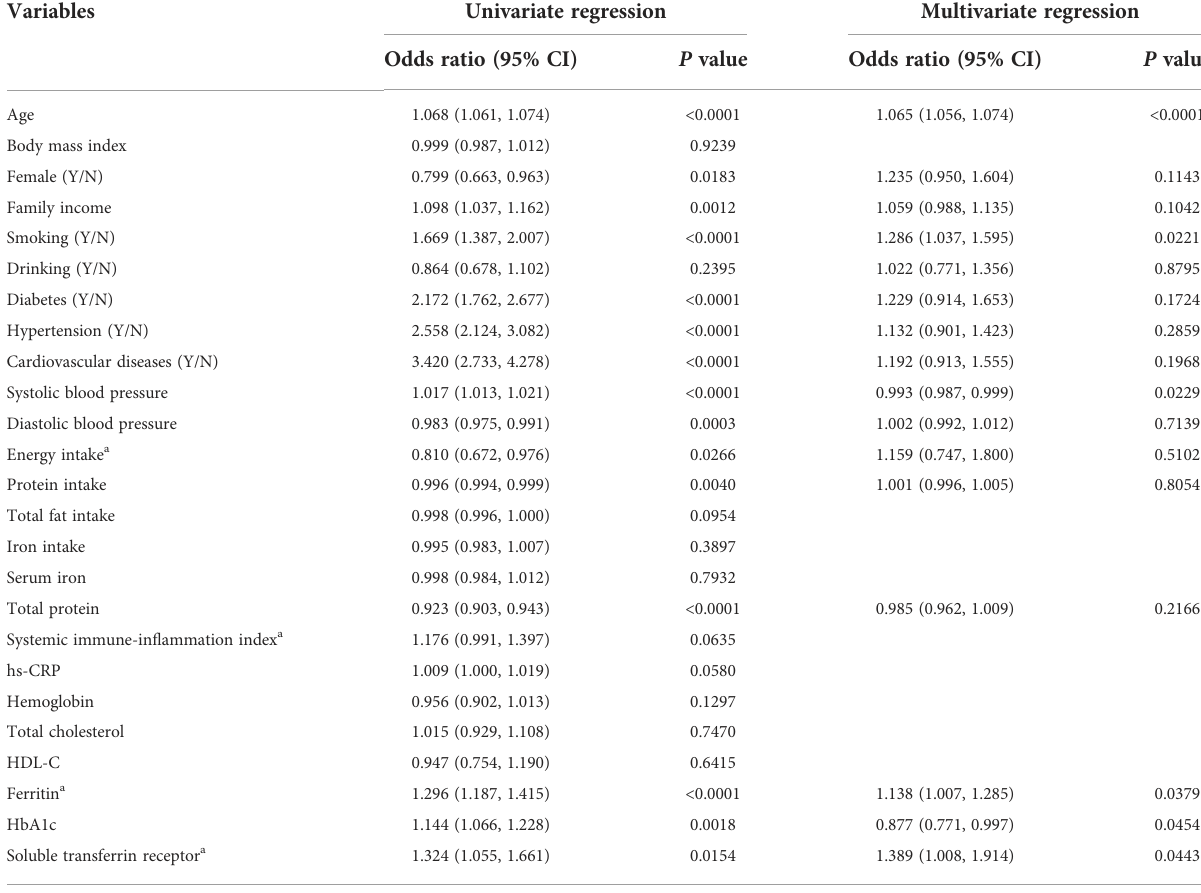
TABLE 2 Analysis of clinical factors related to total cancers in univariate and multivariate regression. Variables Univariate regression Multivariate